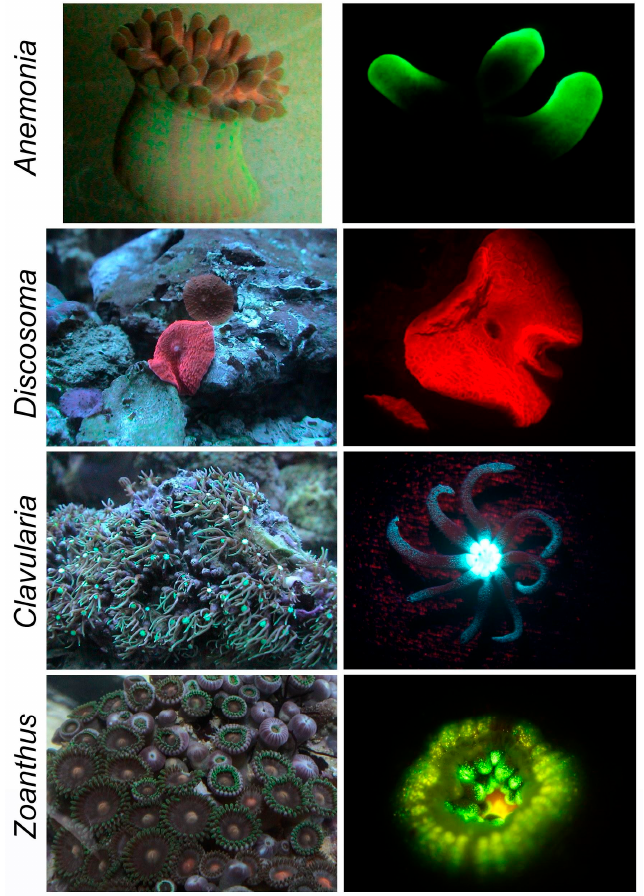
Figure 1. Anthozoa specimen used in this work. Left-general view, right-view of individual polyps or tentacles under a fluorescence stereomicroscope.